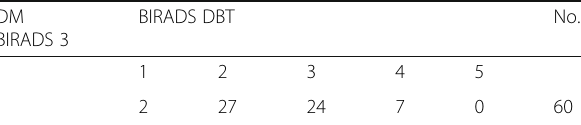
Table 4 BIRADS 3 lesions following DBT DM BIRADS 3